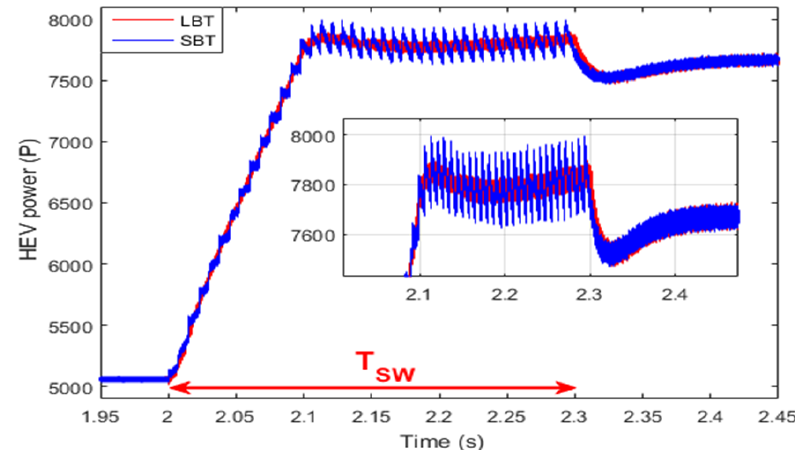
Figure 20. Control system-based STA.